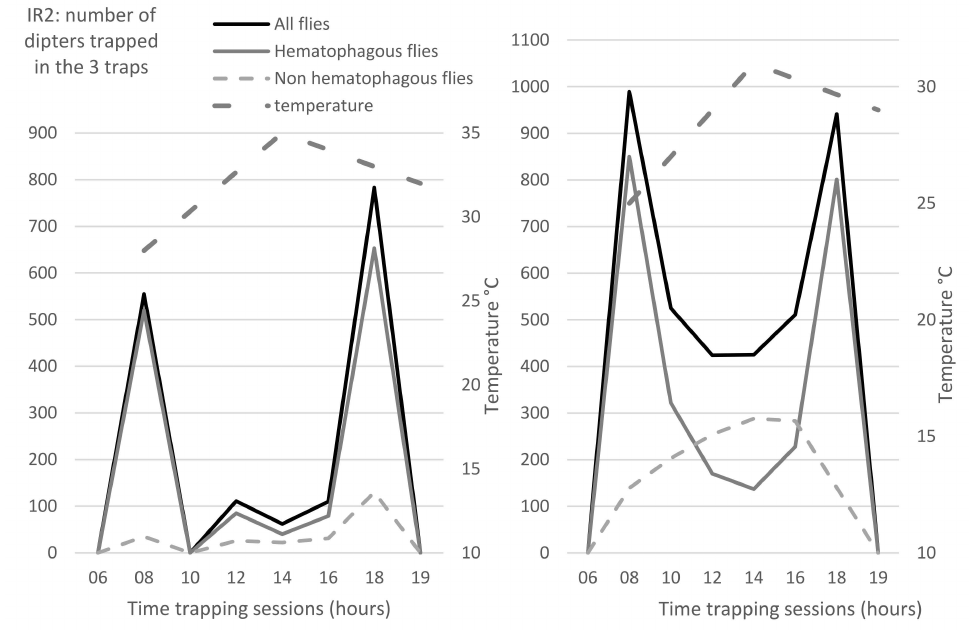
Figure 4. Examples of bimodal daily temporal distribution of flies, from 06:00 to 18:00 and mean temperatures (at 8:00, 14:00 and 19:00) on 17 August 2016 ( a ) and 2 November 2016 ( b ). Legend : Black continuous line: total flies; grey continuous line: hematophagous flies; grey broken line: common flies; dot and dash grey line: mean temperature. Arbitrary value of zero was given to the IR at 06:00 and 19:00 to complete the daily graphs. For mean temperatures, data were obtained from the meteorological station of Nakhon Pathom Agromet,